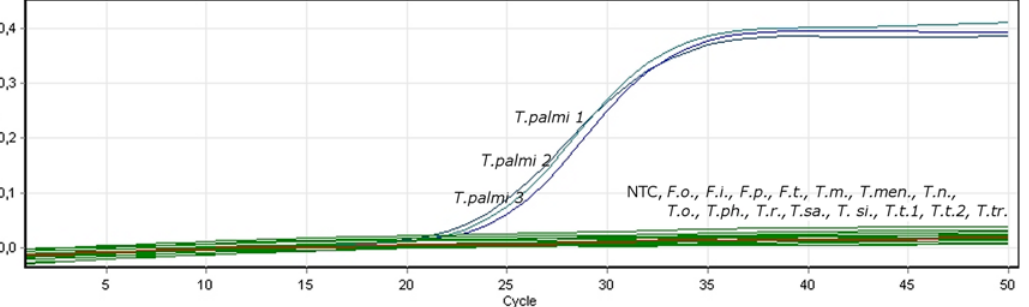
Fig 2. Results of LAMP reaction using real-time monitoring. F.o. — Frankliniella occidentalis , F.i. — F . intonsa , F.p. — F . pallida , F.t. — F . tenuicornis , T.m. — Thrips major , T.men. — T . menyanthidis , T.n. — T . nigropilosus , T.o. — T . origani , T.ph. — T . physapus , T.r. — T . roepkei , T.si. — T . simplex , T.sm. — T . sambuci , T.t. — T . tabaci , T.tr. — T . trehernei , NTC — no template control.